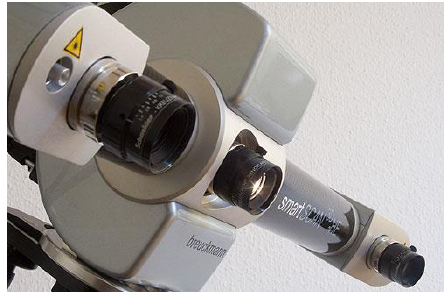
Figure 1: SmartSCAN 3D-HE structured light system